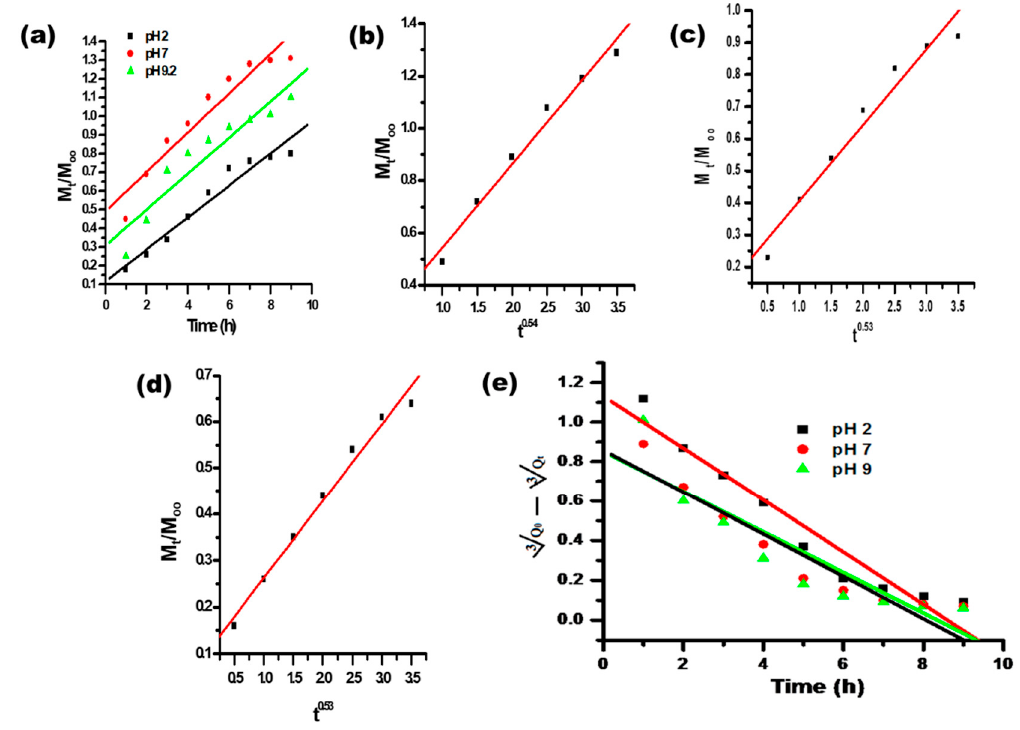
Figure 9. ( a ) Plot of M t /M ∞ vs. time; ( b ) plots of M t /M ∞ vs. t n (n = 0.54) at pH 7; ( c ) plots of M t /M ∞ vs. t n (n = 0.53) at pH 2; ( d ) plots of M t /M ∞ vs. t n (n = 0.53) at pH 9.2; and ( e ) plot of root cube of √ Qo- √ Q t vs. time for the release of itraconazole from the synthesized CH-Ag bionanocomposite.